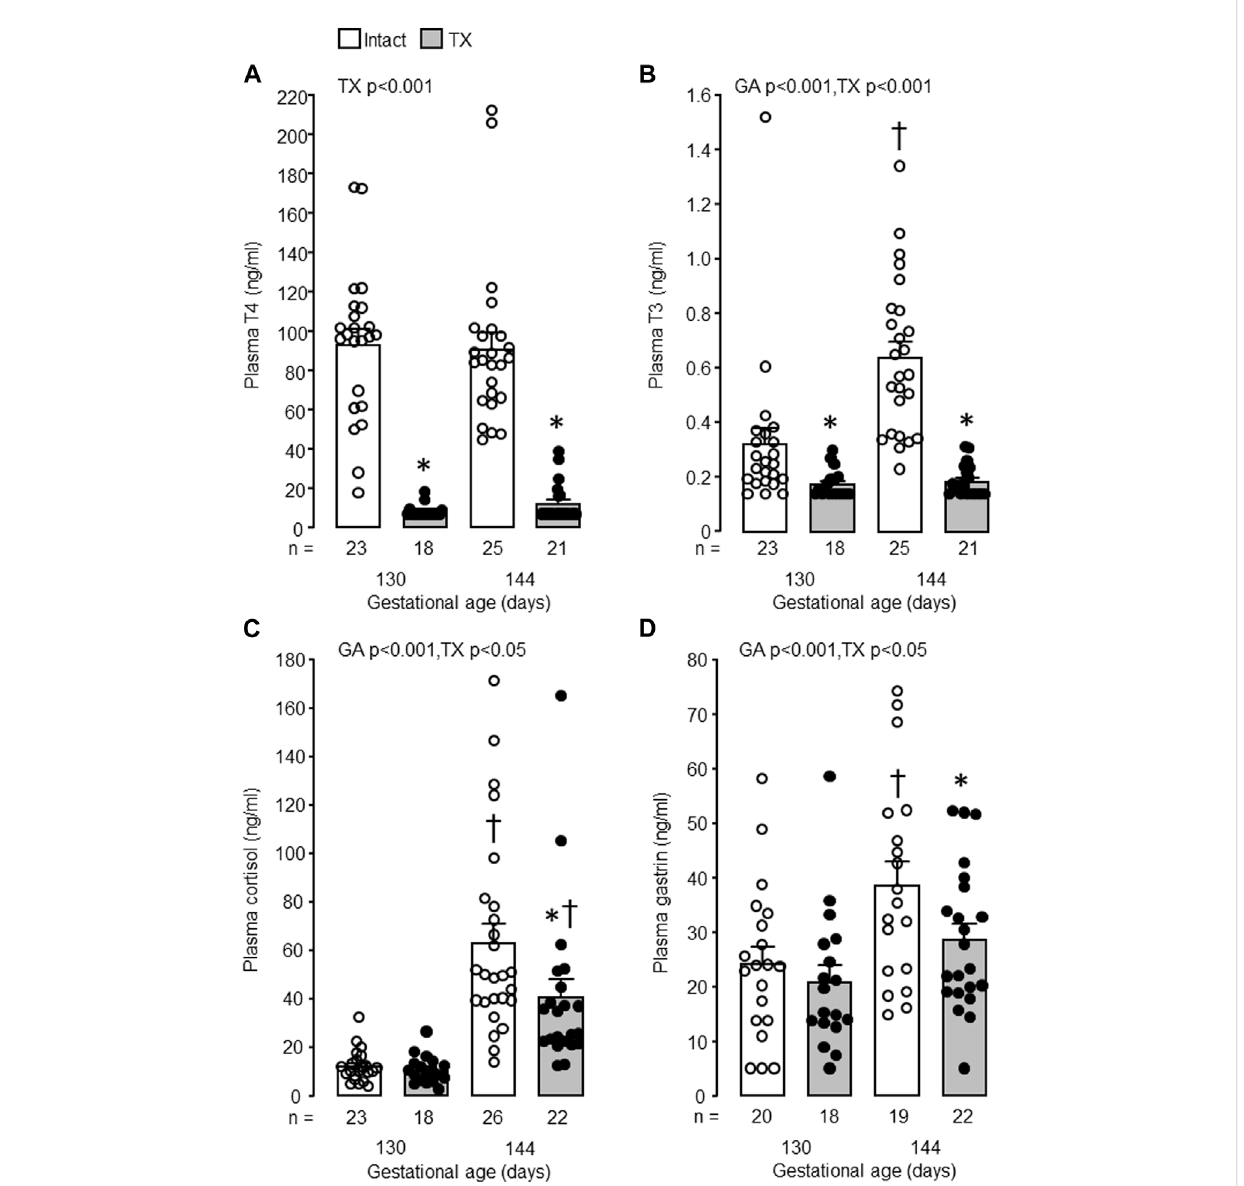
FIGURE 3 Mean (±SEM) and individual plasma concentrations of (A) thyroxine (T4), (B) triiodothyronine (T3), (C) cortisol and (D) gastrin in the intact and TX fetuses at130and 144 days ofgestation. *,signi fi cant differencefrom intactfetusesatthesame gestational age ( p < 0.05, Tukey ’ s posthoc testfollowing two-way ANOVA); † ,signi fi cantdifferencefromfetusesofthesametreatmentat130 days ofgestation( p < 0.05, Tukey ’ s posthoc testfollowingtwo-way ANOVA). Numbers of fetuses in each group are indicated at the base of the histogram. GA, gestational age; TX, thyroidectomy.